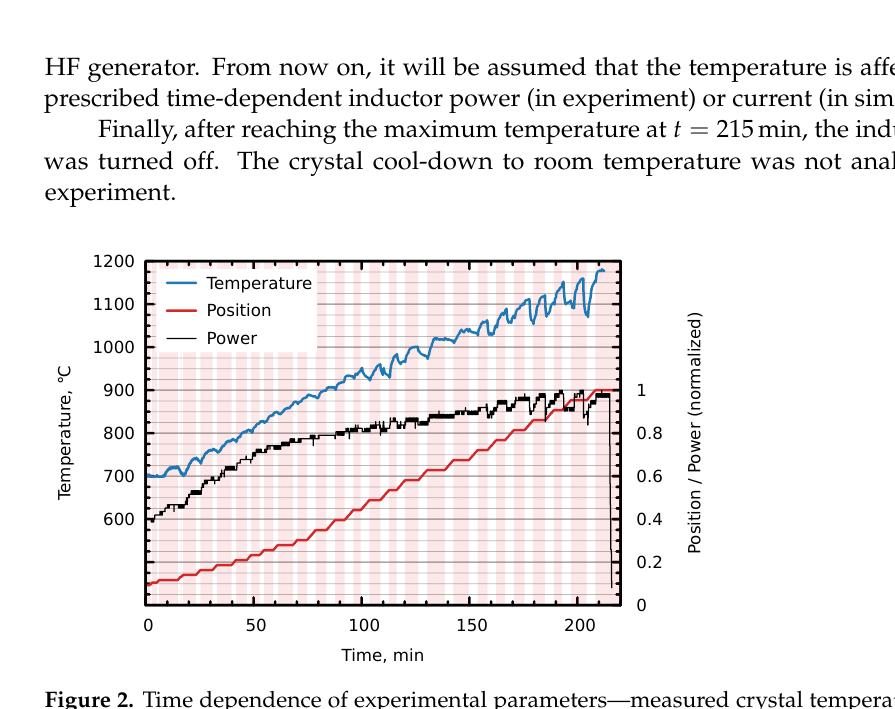
Figure 2. Time dependence of experimental parameters—measured crystal temperature (average over the circular region in Figure 1), heating (crystal) position, and HF inductor power. Highlighted areas show time intervals at which the crystal is